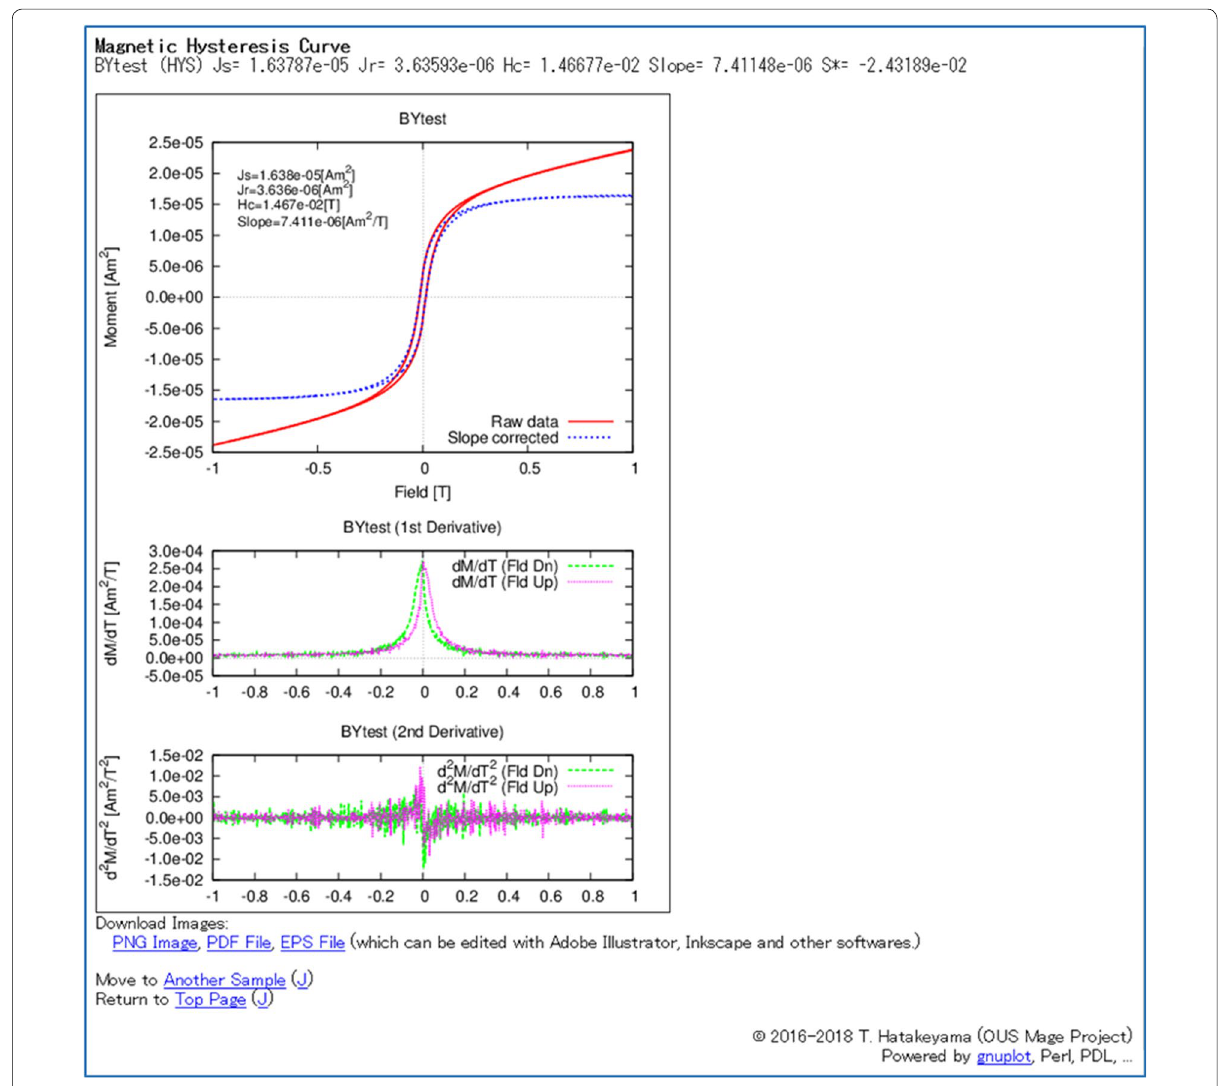
Fig. 5 Screenshot of the results window of the MagePlot/H service after selecting the option to plot the first and second